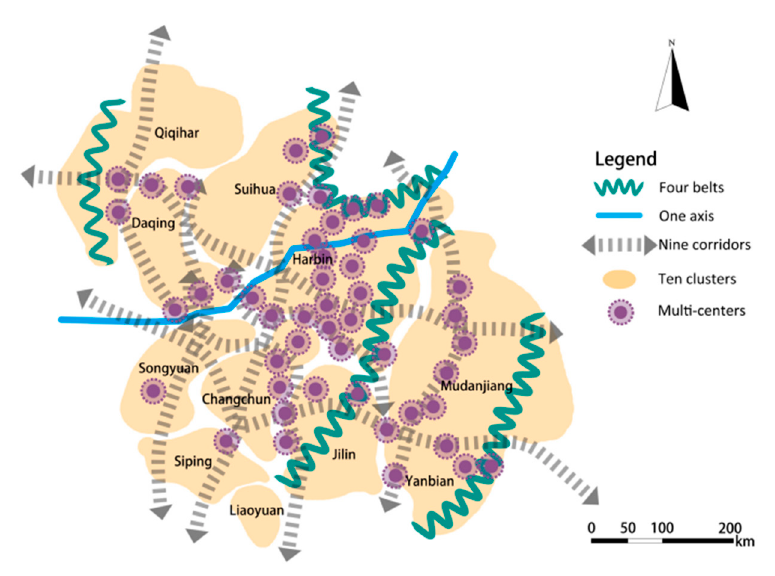
Figure 8. Optimized Spatial Distribution Map of ESP.